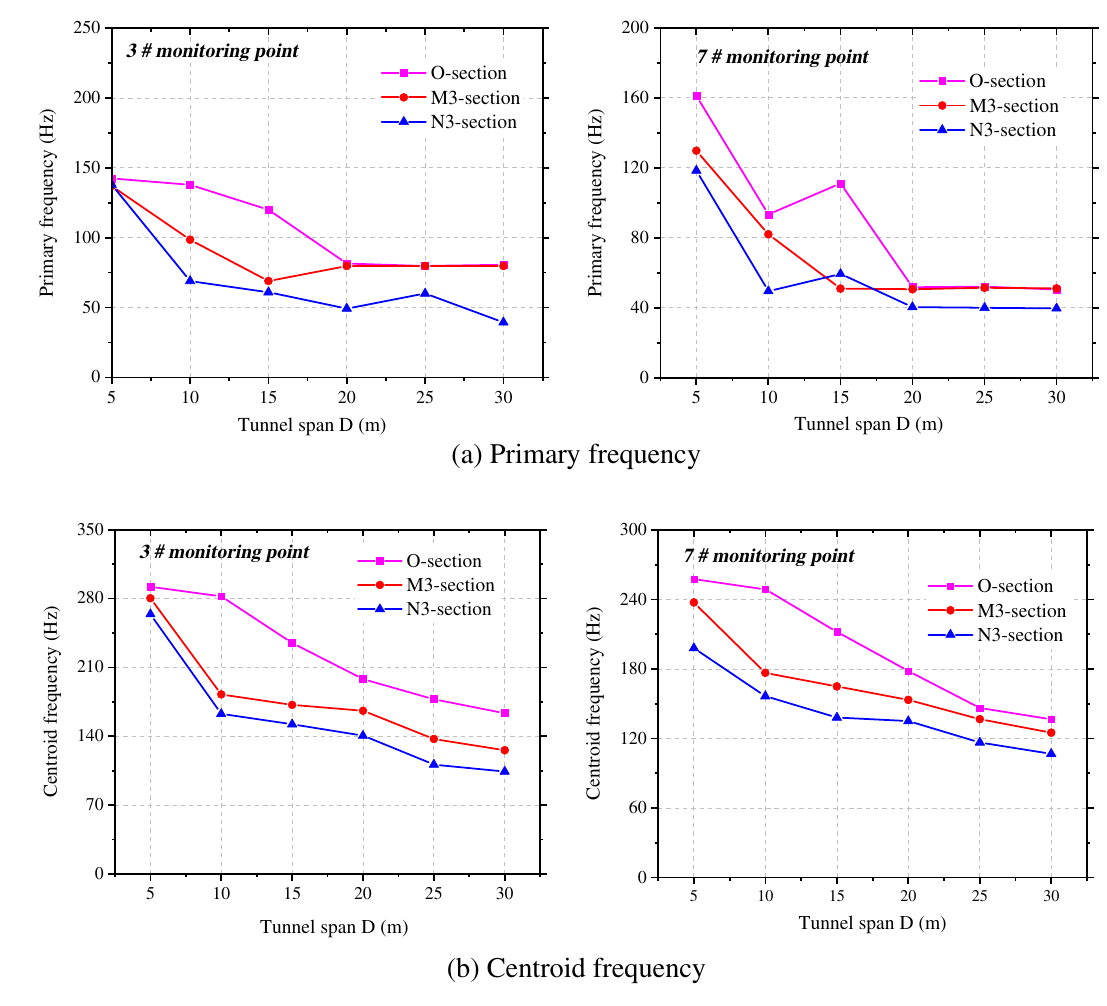
Figure 15. Frequency attenuation law of measuring point 3# and 7# under different tunnel spans.